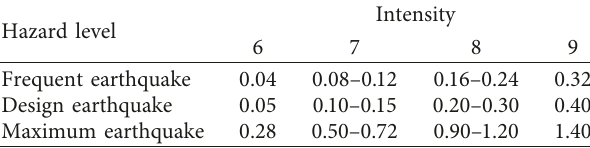
Table 6: Parameter α max of the Chinese code